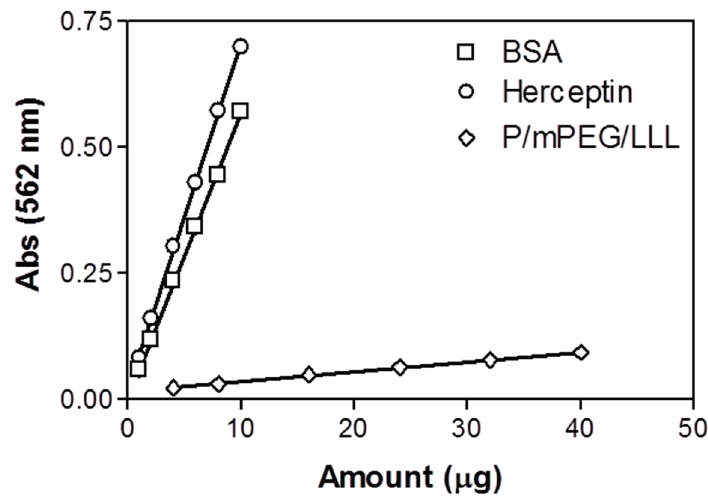
Figure 5. Standard curves for Herceptin, BSA, and P/mPEG/LLL obtained using BCA method. Data are triplicate with standard